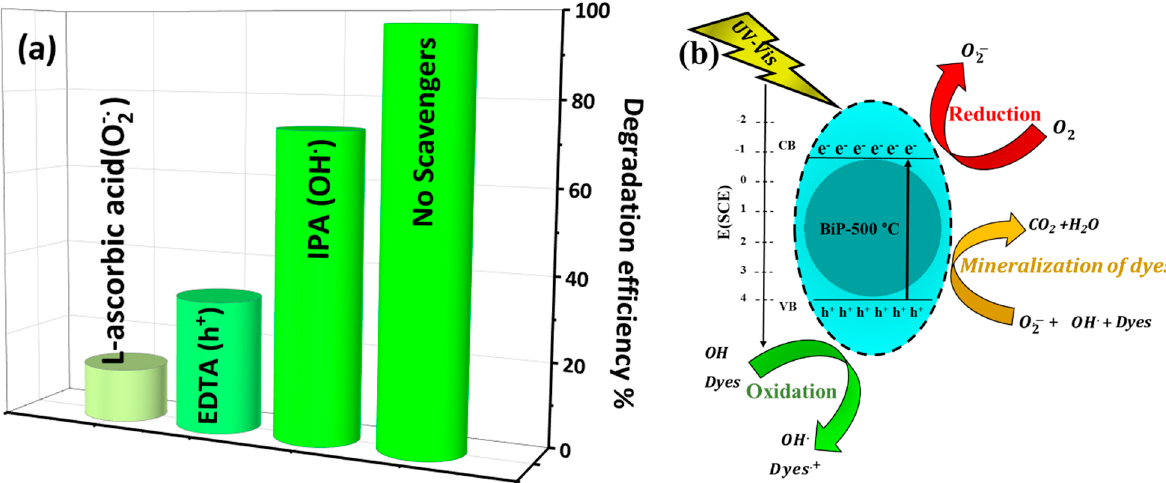
Figure 15. ( a ) Photocatalytic degradation of RhB using BiPO 4 in the presence of a series of scaven- gers. Irradiation time: 12 min, RhB = 5 mg.L − 1 and (scavenger) = 4 mmol.L − 1 . ( b ) Schematic diagram representing proposed degradation mechanism of BiP-500 °C.